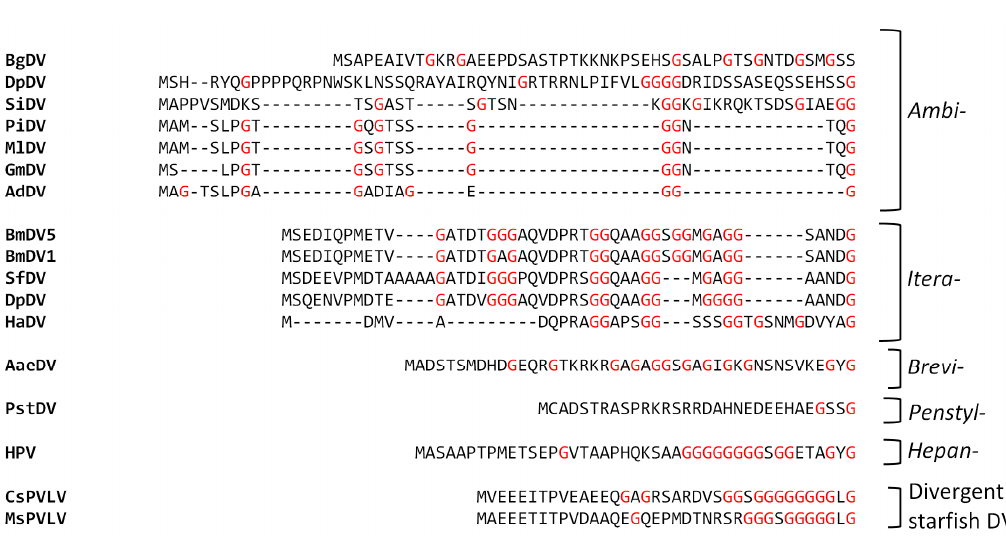
Figure 10. Disorder prediction for densoviruses. AdDV (blue), BmDV1 (pink), GmDV (green), and PstDV (black) VP1. The PONDR_fit application was utilized [72]. Regions above 0.5 on the Y ‐ axis are predicted to be disordered. The approximate locations of the VPs are indicated in the grey bars above. In case of AdDV, both VP1 and VP2 have unique N ‐ terminal regions. The regions highlighted in light blue in the disorder plot indicate the locations of the surface exposed loops, their apexes are VRs.